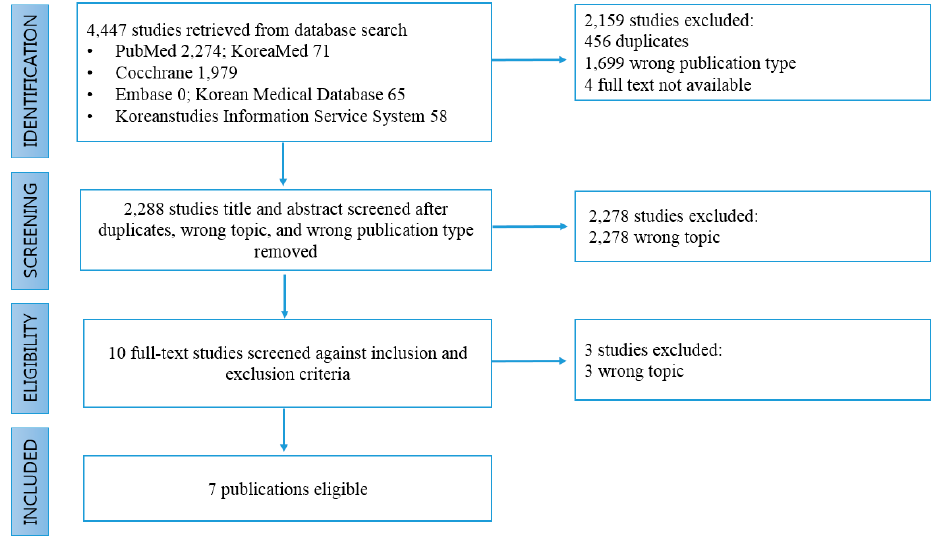
Figure 3. PRISMA flow diagram.